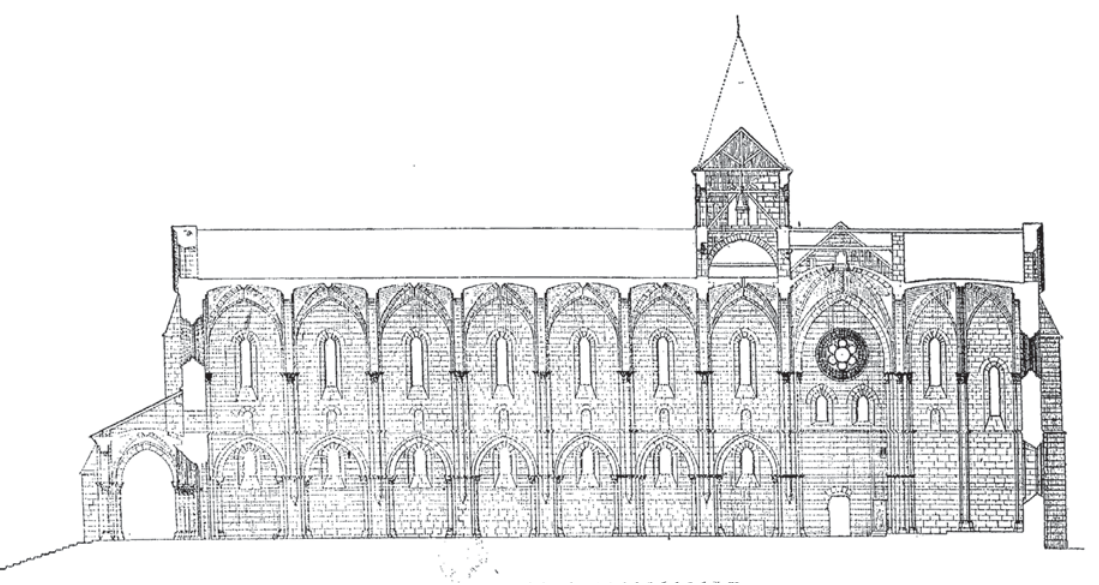
Figure 1c. The Abbey of Casamari (Veroli): Longitudinal section, Elaboration by C. Enlart (1894)